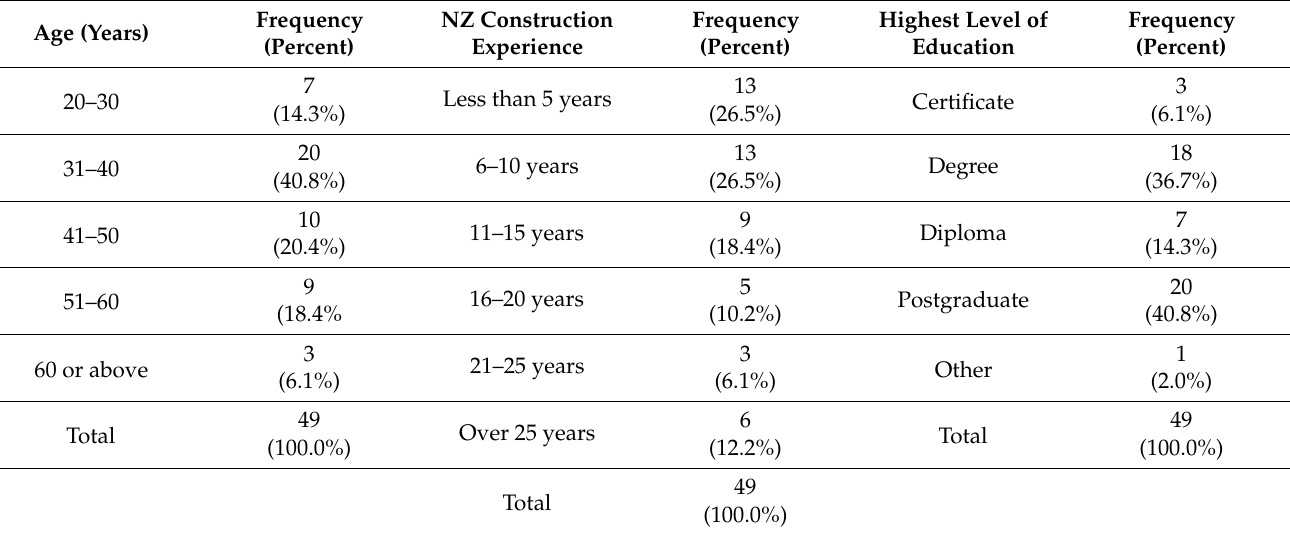
Table 1. Profile of the survey